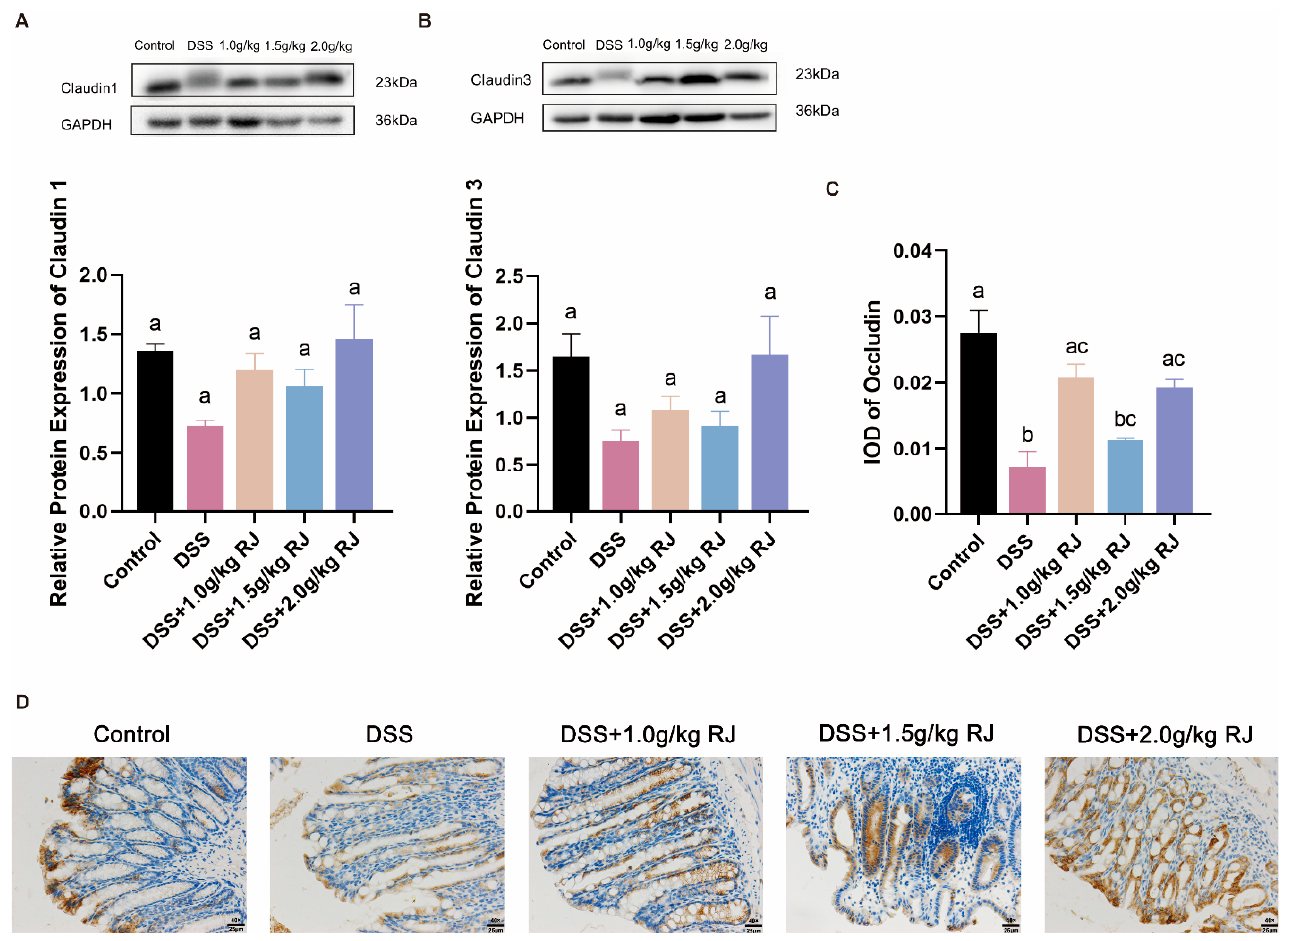
Figure 3. Oral administration of royal jelly increased the expression of tight-junction protein in the colonic mucosa of mice with ulcerative colitis induced by DSS. Protein bands and statistical analysis of colonic tight-junction proteins claudin 1 ( A ) and claudin 3 ( B ) by Western blotting ( n = 3); Immunohistochemical staining ( C ) and mean of IOD statistics ( D ) of colonic tight-junction protein occludin ( n = 3). The scale bar is 25 µ m. Data were expressed as mean ± standard error (SEM). The groups marked with different letters had significant differences.